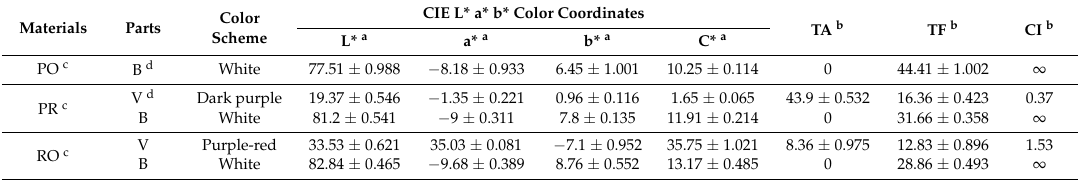
Table 1. The Flower color, TA, TF and CI of the background and variegation of materials at fully open stage.